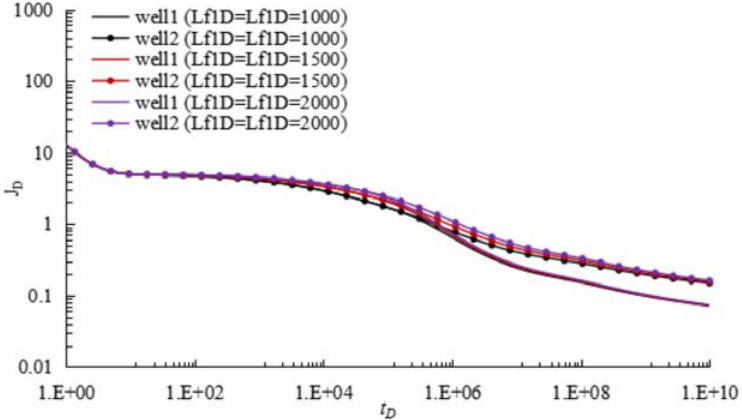
Figure 12. Effects of fracture half ‐ length on MPI for WIPS scheme.